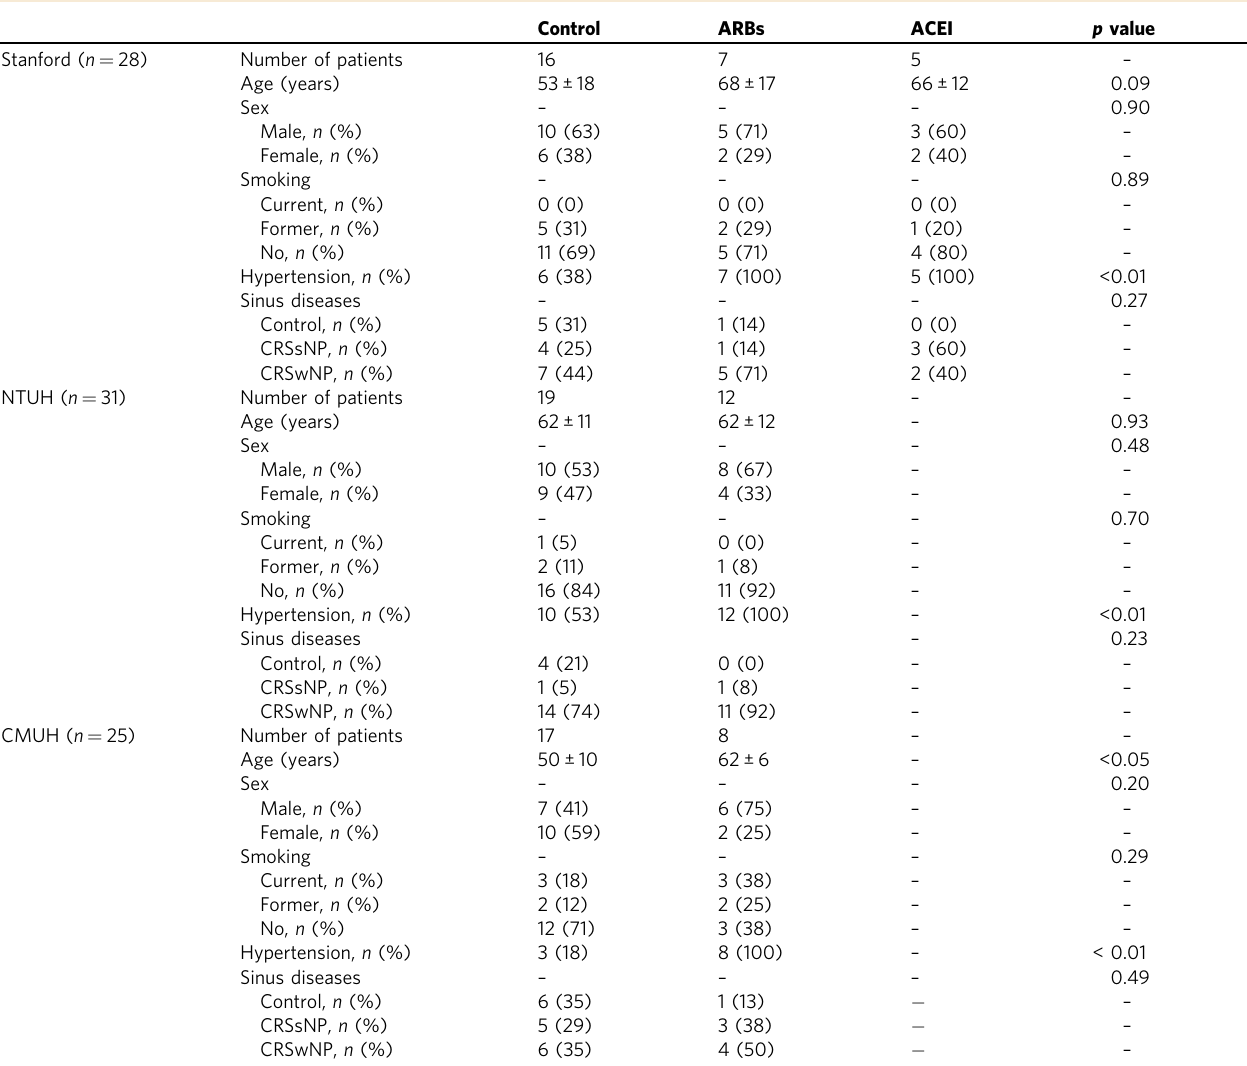
Table 1 Demographic summary of